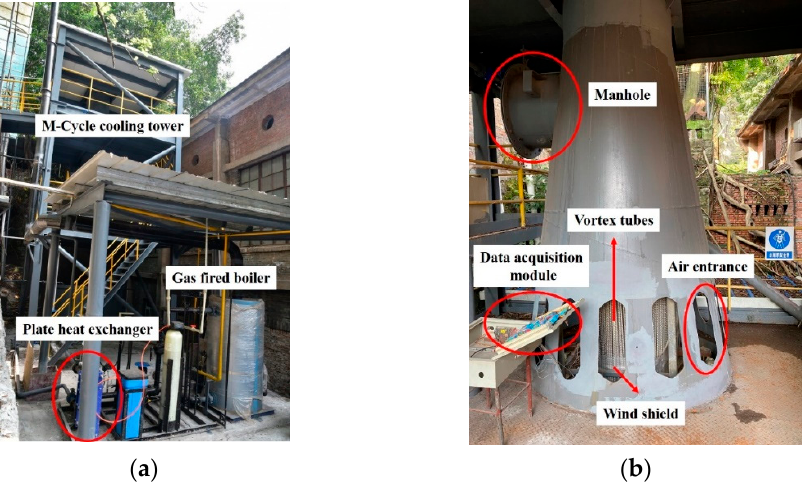
Figure 4. ( a ) The overall layout of the experimental system, and ( b ) the arrangement of the novel fill with uneven length of dry and wet channels.